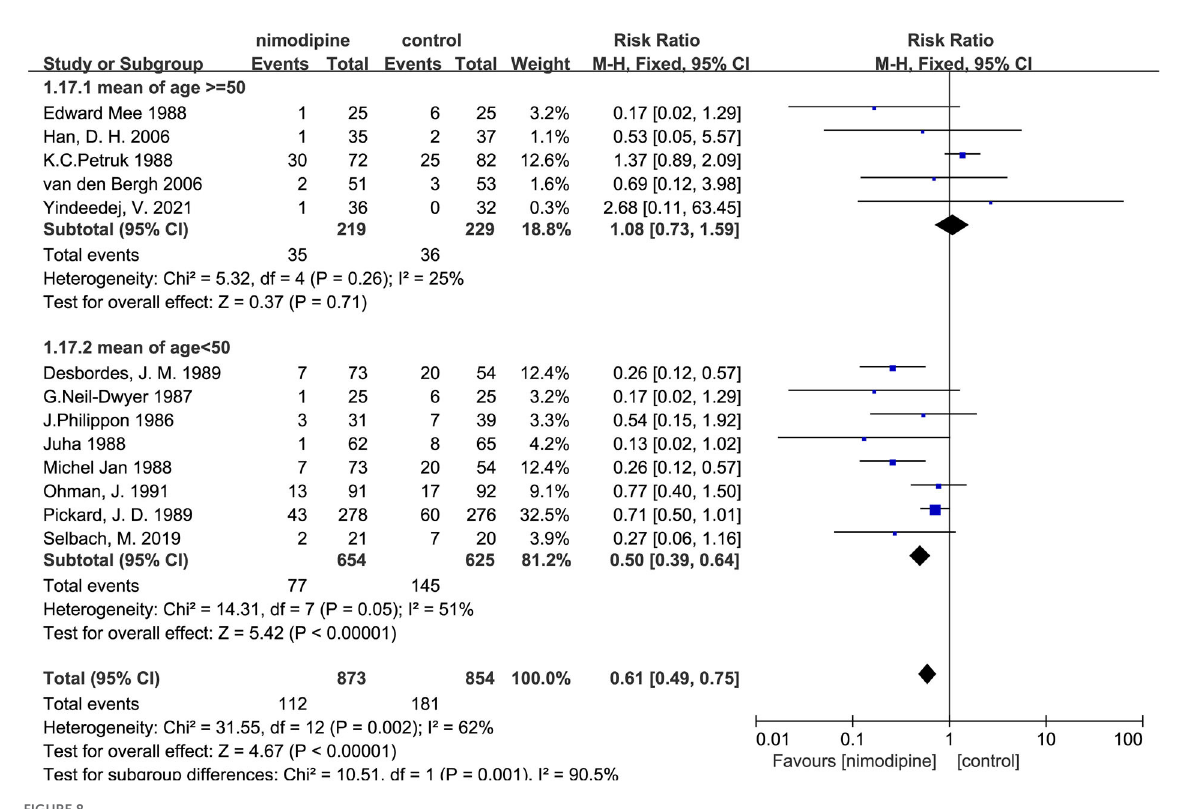
FIGURE8 Subgroup analysis of mortality according to the mean age.